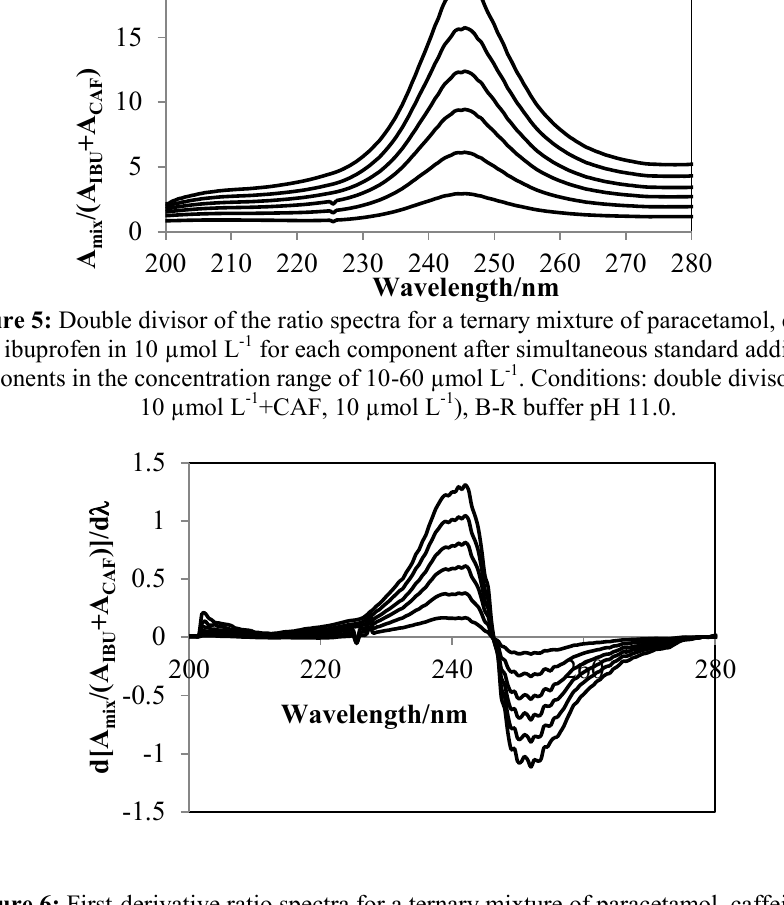
Figure 6: First-derivative ratio spectra for a ternary mixture of paracetamol, caffeine and ibuprofen in 10 µmol L -1 after simultaneous standard addition of components in the concentration range of 10-60 µmol L -1 . Conditions: double divisors (IBU, 10 µmol L -